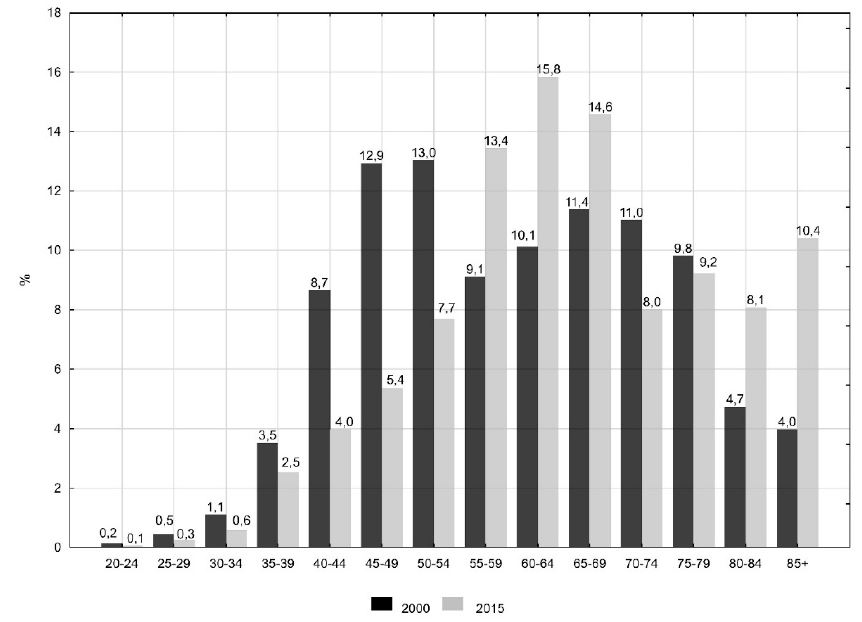
Figure 1. Percentage of deaths due to cervical cancer by age groups in the years 2000 and 2015 in Poland. Table 1. Number of deaths and values of crude death rate (CDR), standardized death rates (SDR), standard expected years of life lost (SEYLL), standard expected years of life lost per living person (SEYLL p ), and standard expected years of life lost per death (SEYLL d ) due to cervical cancer in Poland in 2000 to 2015.